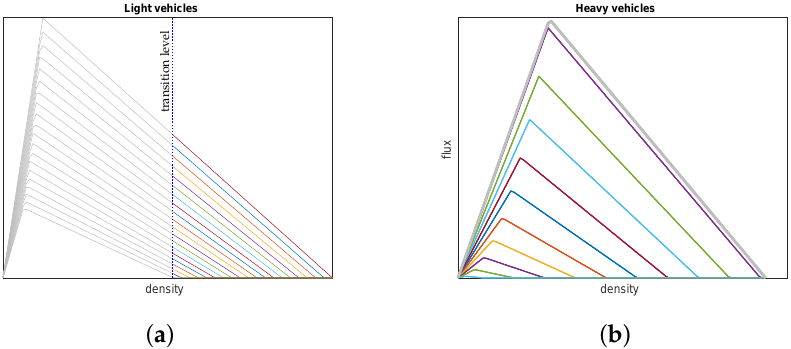
Figure 7. Fundamental diagrams of the macroscopic model in the full coupling phase, i.e., ( ρ ) . ( a ) Light vehicles, ( b ) heavy L , ρ H ∈ D 2